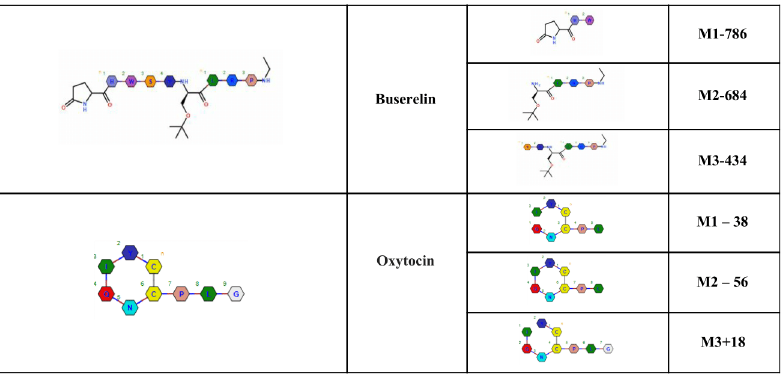
Fig 6. Proposed metabolites of buserelin and oxytocin found in 120 min incubations with